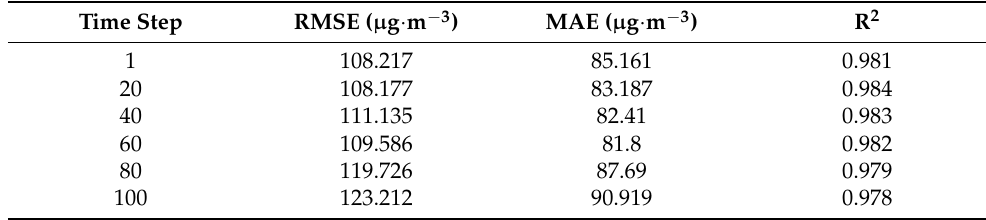
Table 5. Indicators at different time